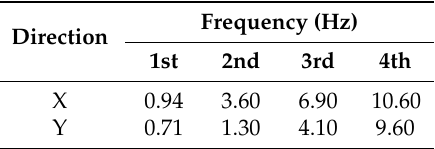
Table 2. Natural frequencies of the #6